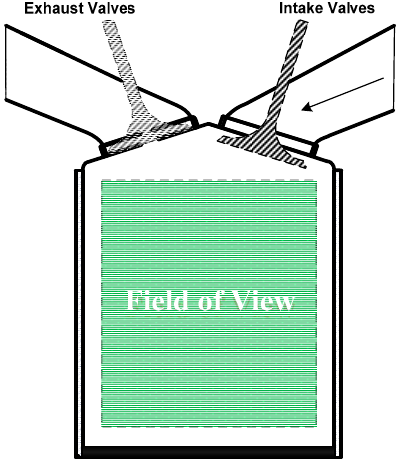
Figure 4. Schematic for the field of view.